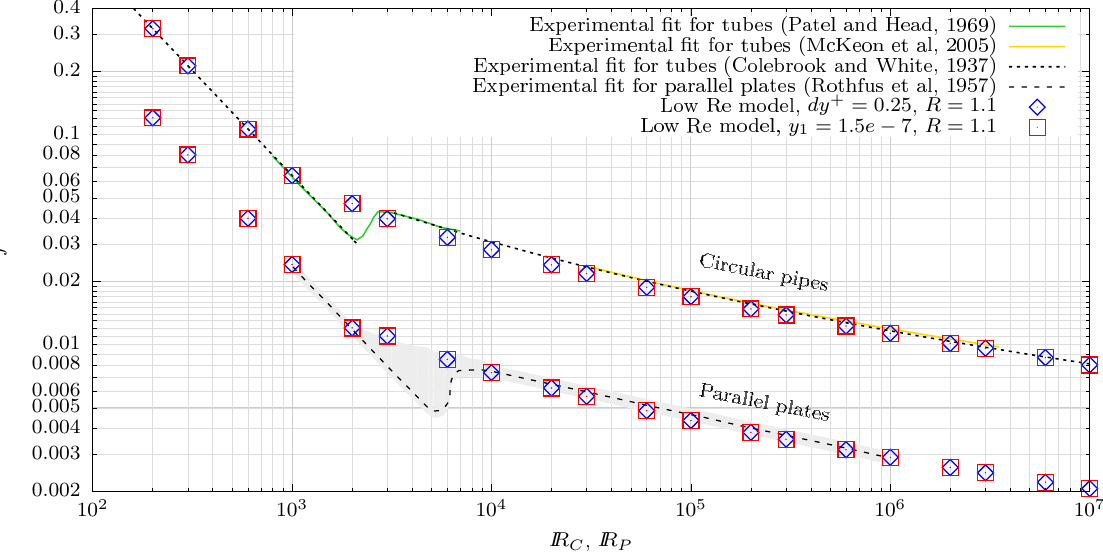
Figure 9: Friction factor from LRN treatment with single mesh.